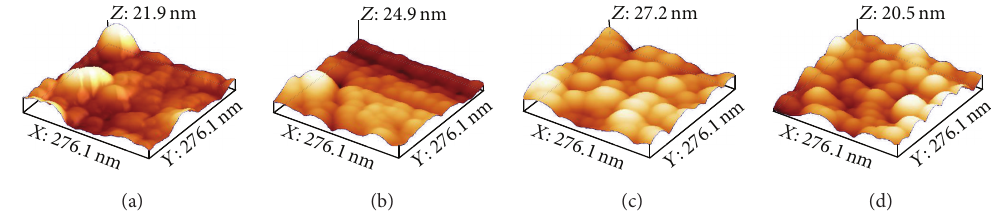
Figure 2: Three-dimensional AFM images of C-Ni films deposited at (a) 50, (b) 90, (c) 180, and (d) 600sec.